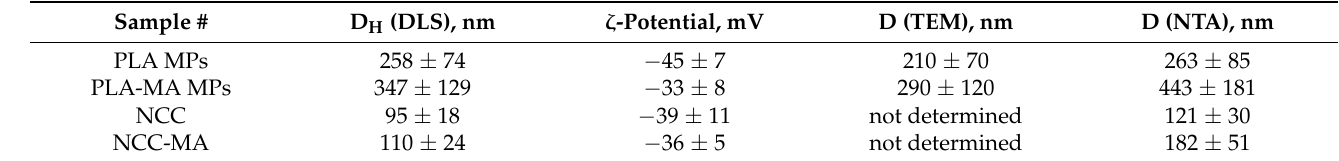
Table 1. Effect of particle modification on particle diameter and surface charge.